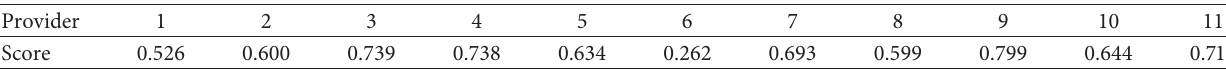
Table 8: The evaluation results of